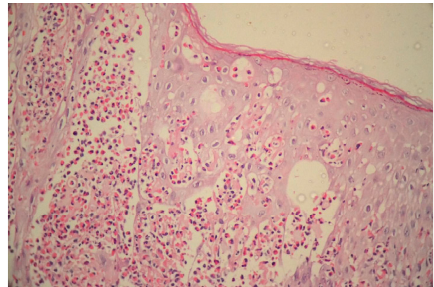
Figure 5: Dyskeratosis with prominent eosinophilic spongiosis and microabscess formation (H&E × 400).